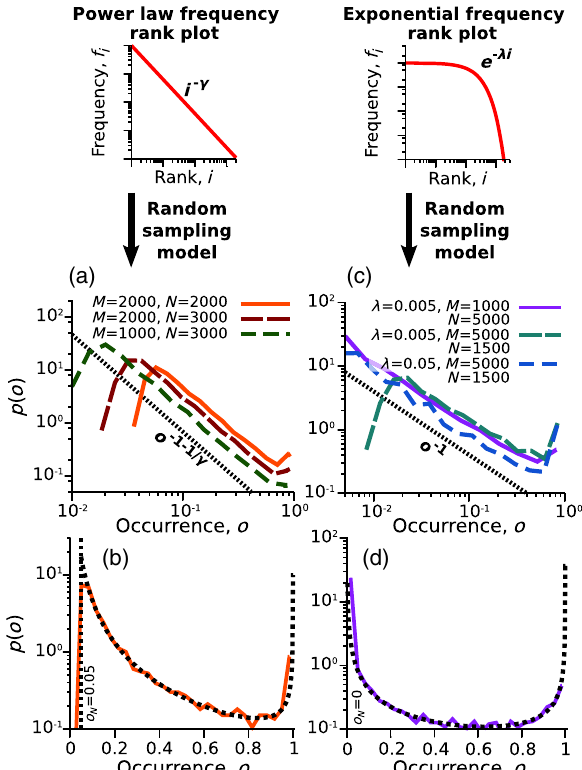
FIG. 4. Power-law decaying and U-shaped component occur- rence distributions may descend from both power-law and exponential distributed universe component frequencies. (a) A power-law rank plot for the frequency (and thus for the abundance), whose exponent is − γ ( γ ¼ 1 . 2 in the plot), produces a power-law decay of the component occurrence distribution with exponent − 1 − ð 1 = γ Þ , independently of the realization size M and the number of components N (for sufficiently large values of these parameters). (b) Agreement between the theoretical pre- diction of Eq. (6) (black line) and a simulated random sampling with parameters R ¼ 1000 , N ¼ 2000 , γ ¼ 1 . 2 , M ¼ 2000 [the black vertical dashed line is the left boundary of the p ð o Þ domain]. Panels (c) and (d) are the counterpart of (a) and (b) for an exponential frequency rank plot. In this case p ð o Þ always decreases with exponent − 1 , for every value of λ , M , and N (sufficiently large). Parameter values are R ¼ 1000 , N ¼ 2000 , λ ¼ 0 . 005 , M ¼ 5000 . Given the system sizes MR in these examples, the number of possible different components essen- ˜ N ≃ N tially coincides with the vocabulary actually sampled; i.e.,